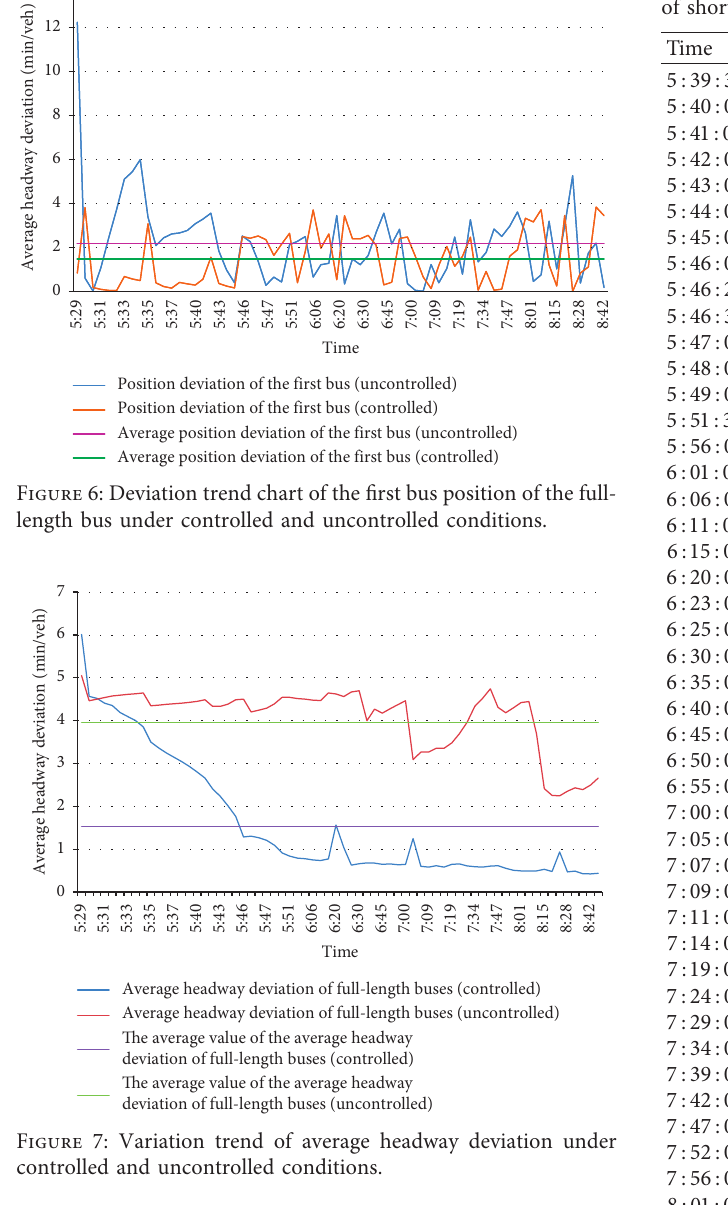
Table 5: Simulation output results under the fleet control strategy of short-turning